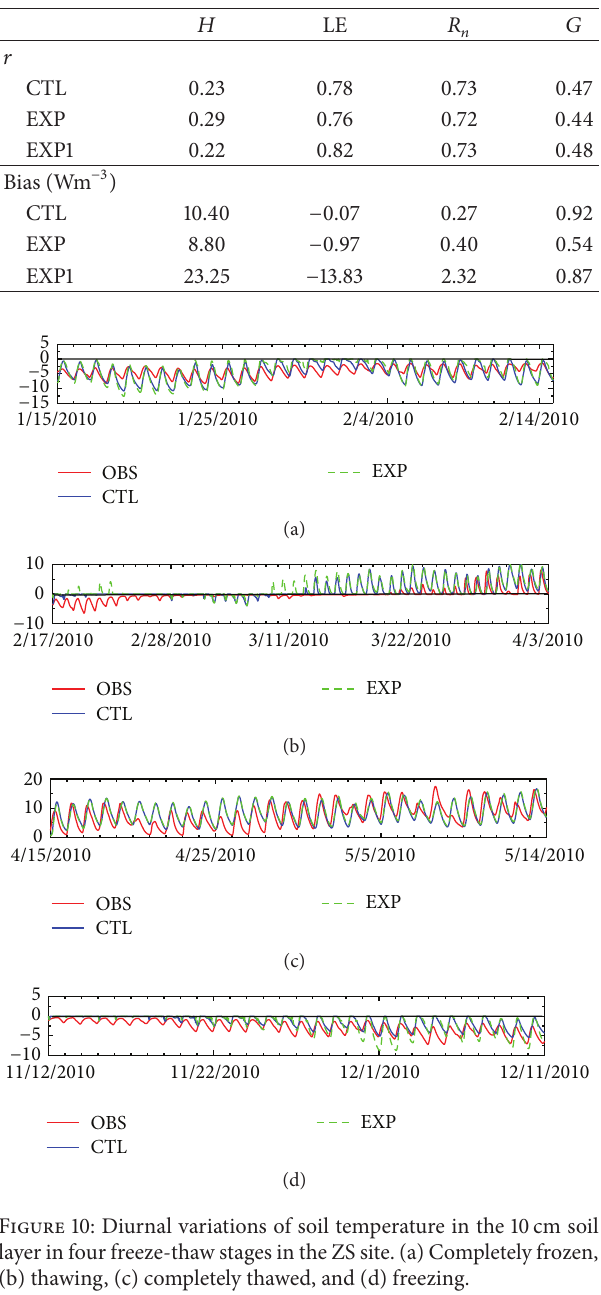
Table 8: Statistical results of daily mean energy flux components between simulations and observation at ZS site.